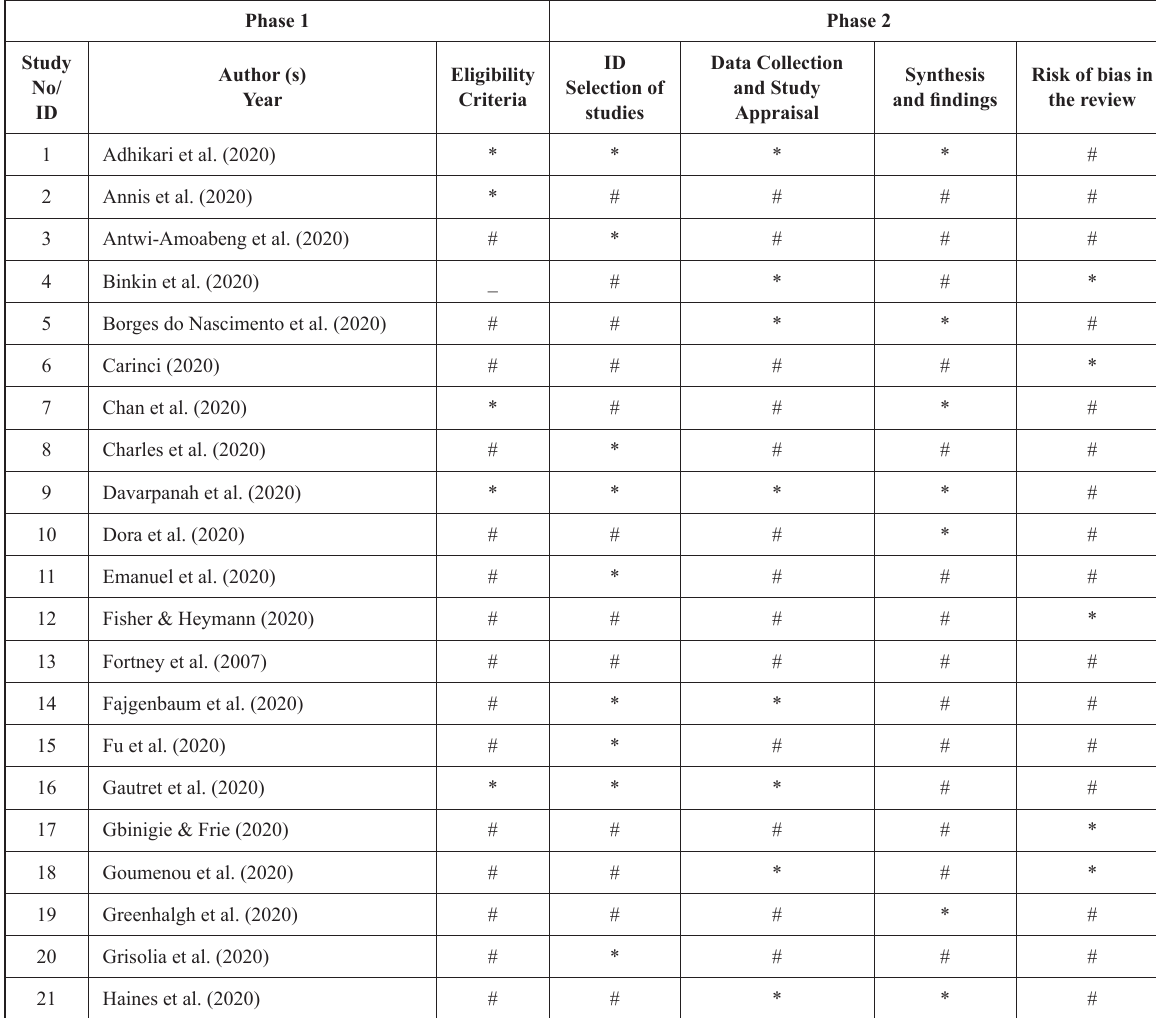
Table 2. ROBIS risk assessment of bias in the systematic review